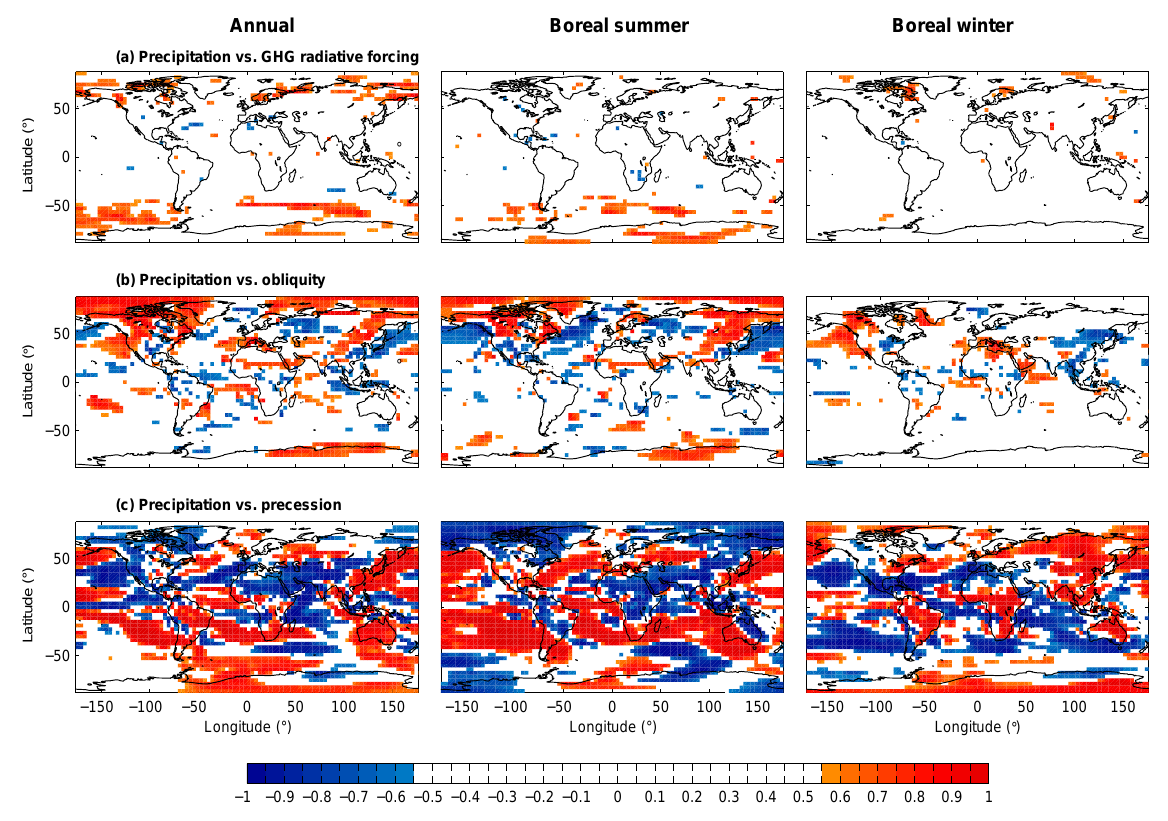
Figure 10. As in Fig. 9, but for